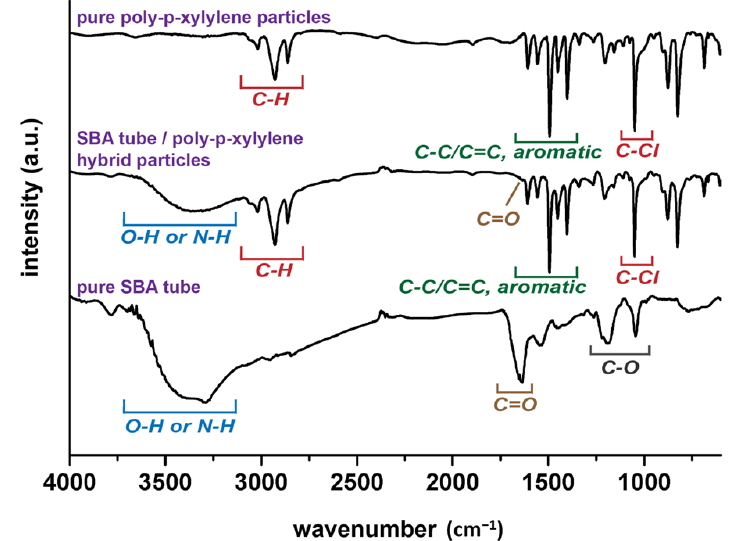
Figure 4. FT-IR spectra showed the chemical composition of the fabricated anisotropic composite particles with poly- p -xylylene as the matrix and the encapsulated SBA proteins. Spectra were also recorded for pure poly- p -xylylene and pure SBA for comparison.